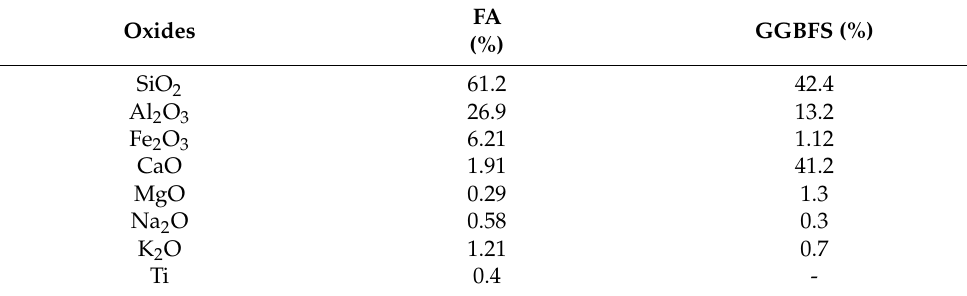
Table 1. The oxide composition of FA and